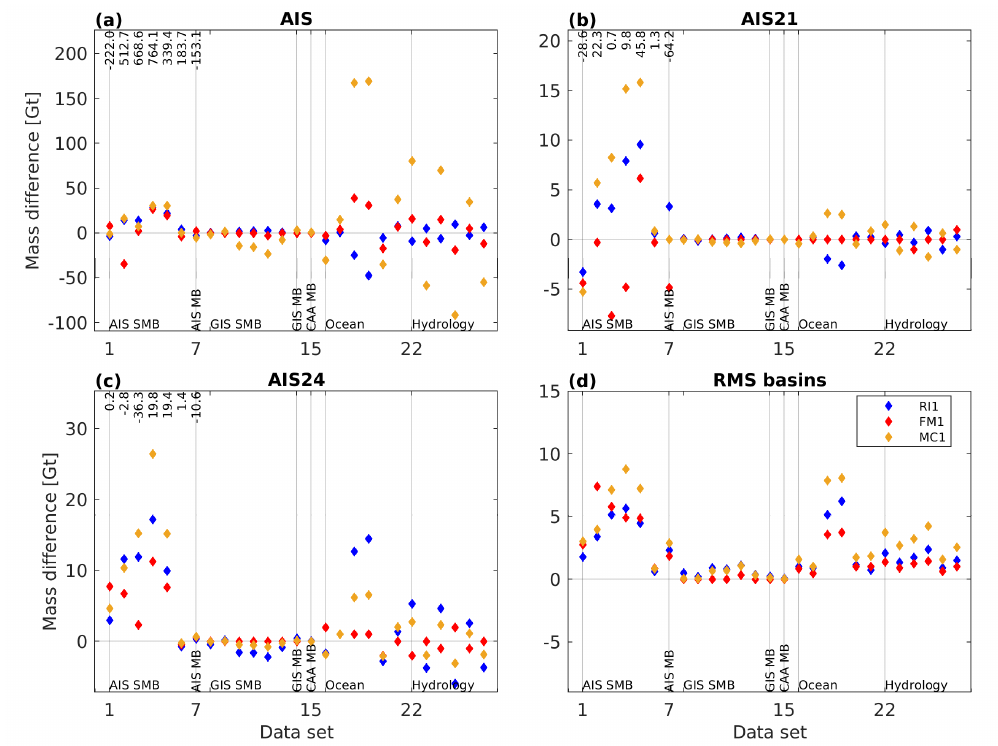
Figure 6. Differences between mass change estimates derived from different synthetic data sets and the corresponding true mass change for ( a ) the AIS as well as drainage basins ( b ) AIS21 and ( c ) AIS24. True (non-zero) mass changes are indicated by numbers at the top margin (unit: gigatons). ( d ) RMS of the differences for all drainage basins (AIS01–AIS24, AIS27,